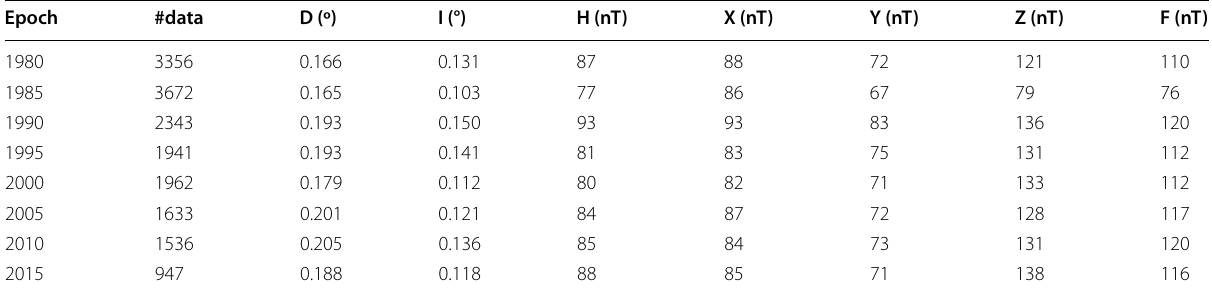
Table 2 The 68.3% confidence intervals of the residuals for each magnetic component per 5-year epoch. Number of data used are for the Declination